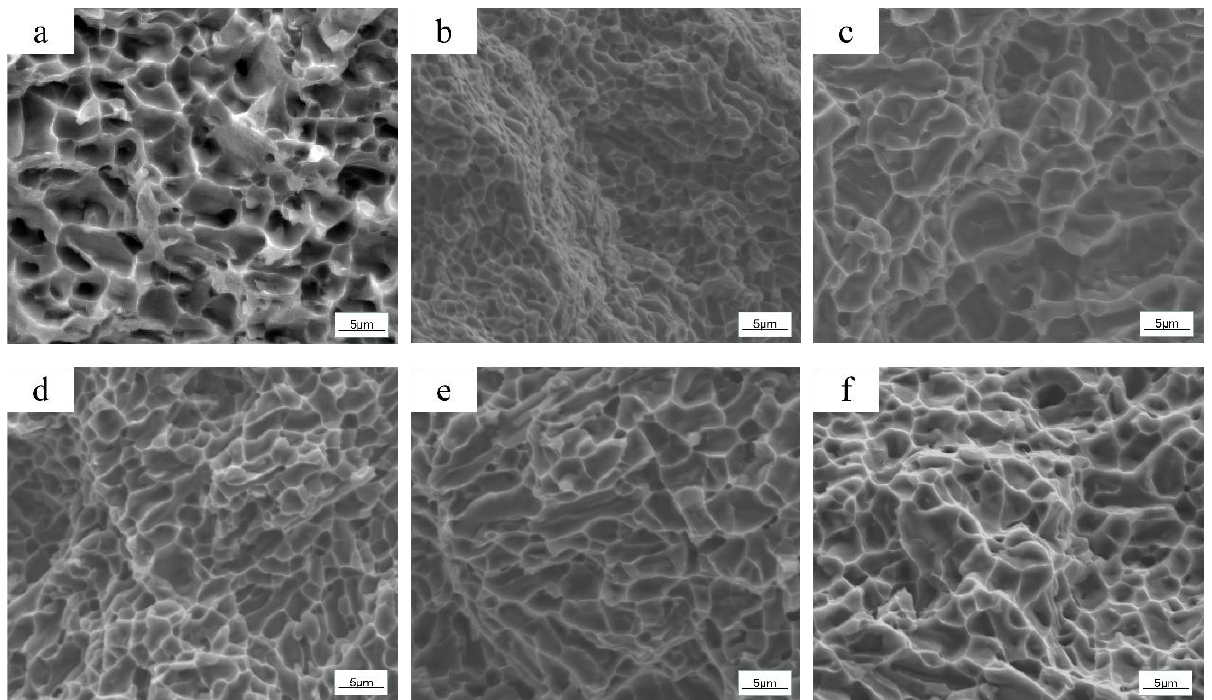
Figure 7. FESEM images showing the tensile fracture surface of the annealed Al-14.5Si alloys solid- ified under a super-gravity field: ( a ) A-0; ( b ) A-0.25; ( c ) A-0.5; ( d ) A-1; ( e ) A-2; ( f ) A-4.